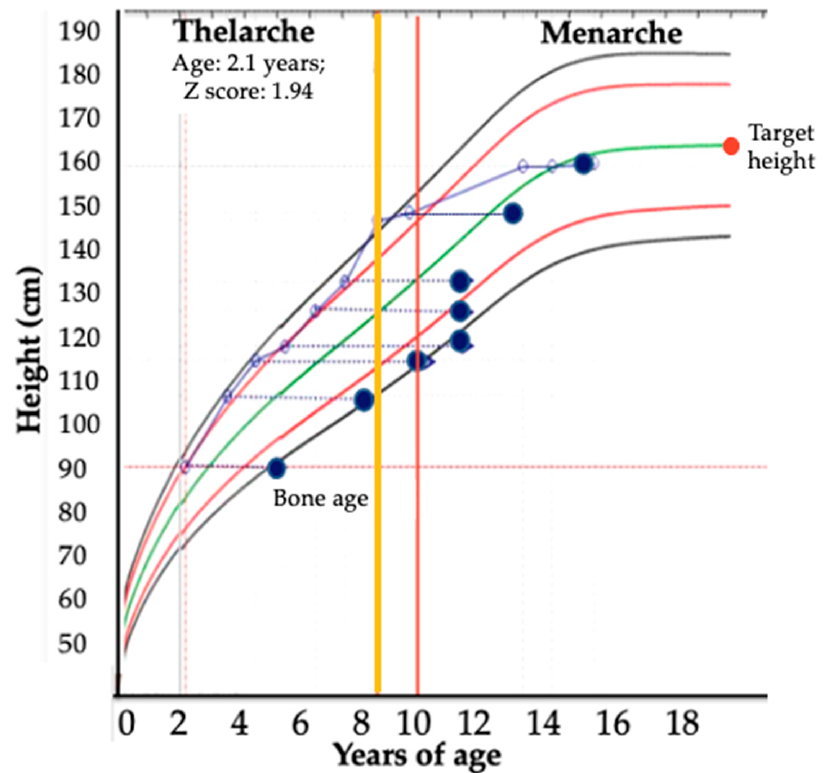
Figure 7. Growth pattern of male patient with PACT, 2 years of age, with mixed syndrome (V + CS), tumor weight of 250 g, sized 12 cm, McFarlane IV, Weiss score 7, Wieneke 4, with TP53- p.R337H and overall survival of 11 months. Blue circle is stature for age and red circle is bone-age.